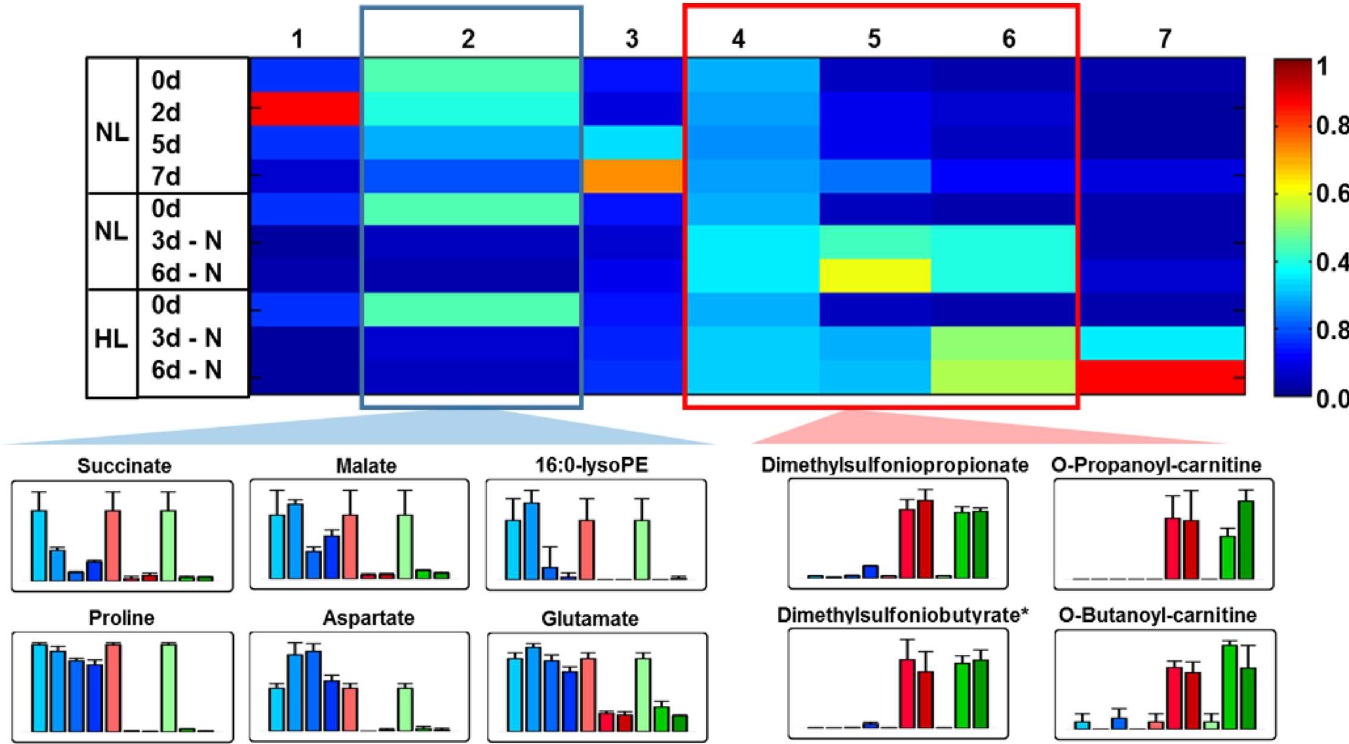
Fig 4. Metabolite fingerprinting analysis of Phaeodactylum tricornutum under replete and N-deplete conditions. Phaeodactylum tricornutum cultures grown under replete conditionand normal light (NL), or grown under N-depleted conditions(-N) and normal light (NL) or high light (HL) were harvestedat the indicated time points and extracted by two phase partitioning. The fingerprint of metabolites of the polar extraction phase was generated by UPLC-TOF-MS analysis. A subset of 935 high-quality features (FDR < 10 − 5 ) derived from the positive as well as the negative ionizationmode were used for clusteringand visualizationby means of one-dimensional self-organizing map (1D-SOM, http://marvis.gobics.de). Prototype 2 (blue frame) represents features with reduced relative amounts under N-depletedconditions, while features combinedin prototype 4–6 (red frame) are enriched under N-depletion. Horizontal and vertical dimensionscorrespondto prototypes and experimental conditions, respectively. The heat map colors represent average intensity values accordingto the color map on the right-hand side. The width of each prototype column is proportional to the number of marker candidates assignedto this prototype. Bar plots show mean values with standard deviations of 3 biologicalreplicates for prominent metabolite markers of the selected clusters. The first 4 bar plots (light to dark blue) show the relative amounts of the compoundsfor replete conditions(0, 3, 5, 7d), while the next bar plots show the data for N-depleteconditions (0, 3, 6d) under normal light (light to dark red) or high light (light to dark green). The identity of the indicatedcompounds was confirmed by high resolutionMS 2 experiments. Visualization was appliedusing VANTED 2.1 software